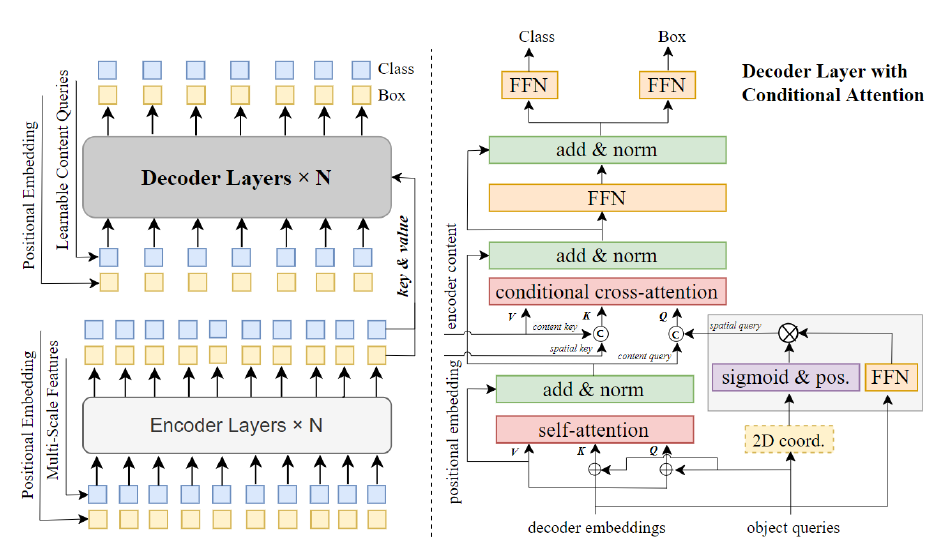
Figure 3. The Transformer with conditional